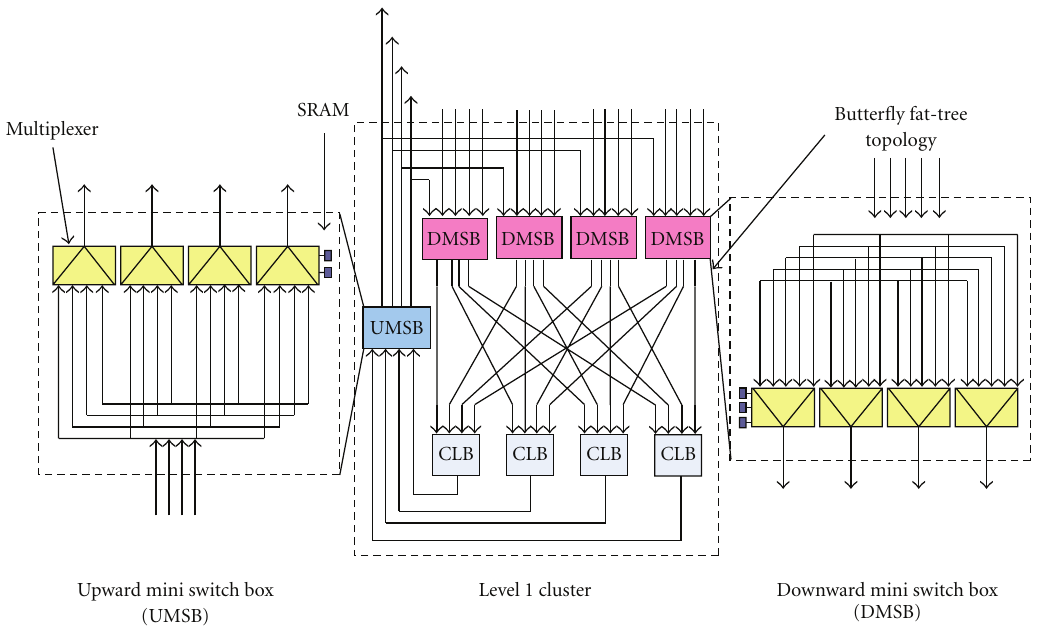
Figure 4: Detailed interconnect of level 1 cluster of tree-based